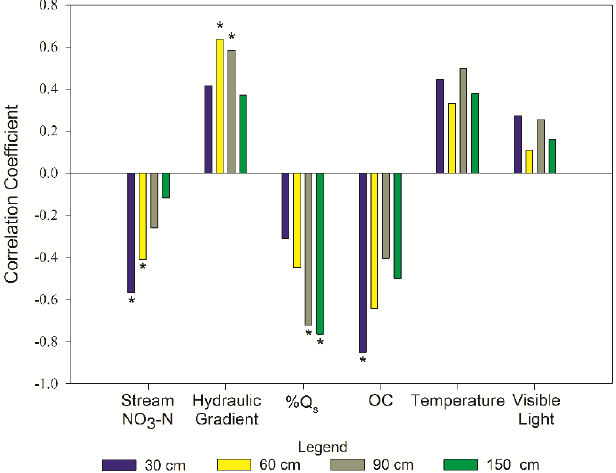
Figure 7. Results of Pearson correlation analyses; asterisk signifies statistically significant relationships.